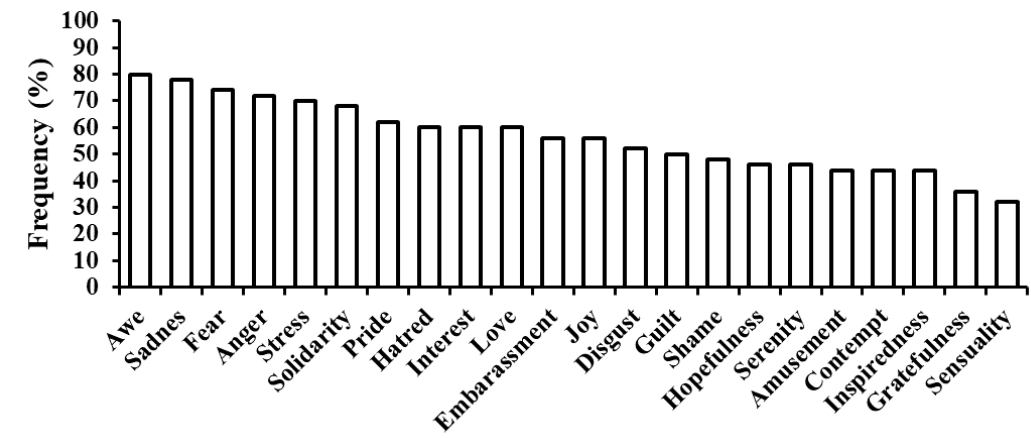
Figure 1. Proportion of participants reporting each of the 22 emotions during the dream.